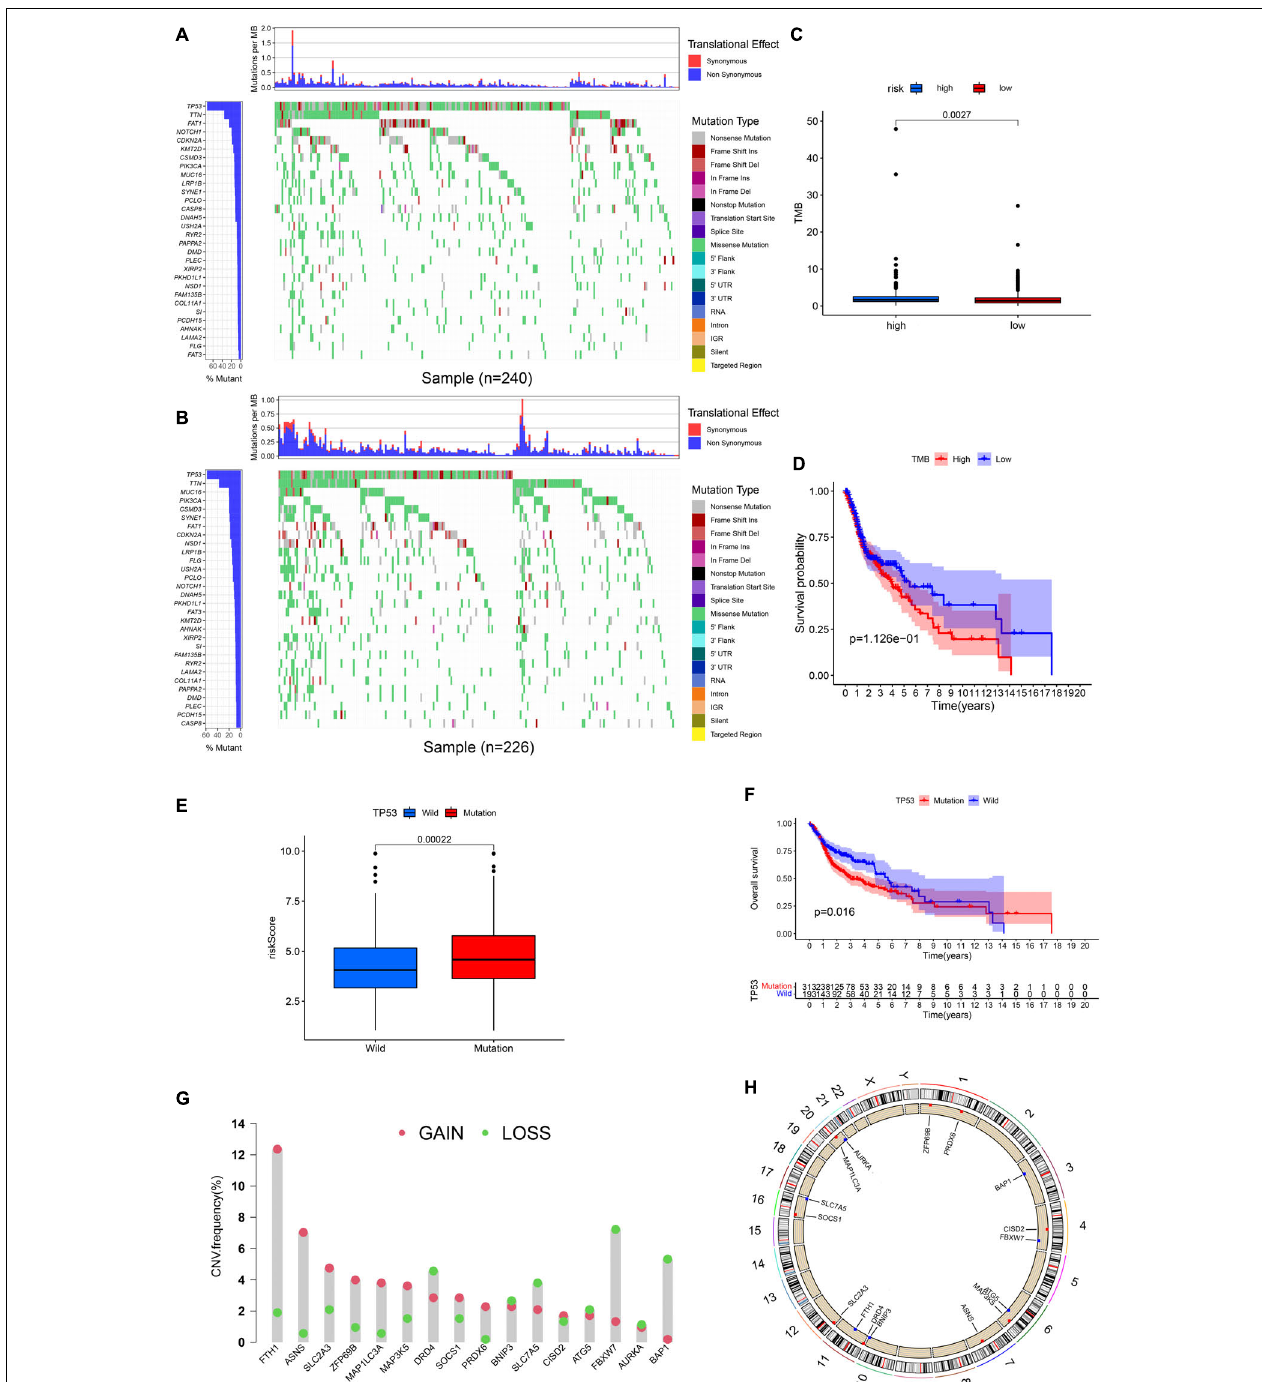
FIGURE 9 | Landscape of Mutation and CNV (copy number variations, CNVs). (A) The waterfall chart shows the mutation distribution of patients in the high-risk group. (B) The waterfall chart shows the mutation distribution of patients in the low-risk group. The left panel of the waterfall plot shows the mutation frequency, and the genes are sorted by their mutation frequency. The figure on the right shows the type of mutation. The histogram above is the statistical data of TMB of each sample. (C) TMB difference between high- and low-risk groups. (D) Survival difference curve of patients between high- and low-TMB groups. (E) Risk score difference between TP53 mutation group and TP53 wild group. (F) Survival difference curve of patients between TP53 mutation group and TP53 wild groups. (G) CNV profile of 17 PR-DE-FRGs. The blue dots represent the loss of copy number; the pink dots represent the gain of copy number. (H) Circle graph shows the location of comprehensive CNV status of 17 PR-DE-FRGs on 23 chromosomes. The blue dot represents the loss of overall copy number, while the red represents the gain in overall copy number.